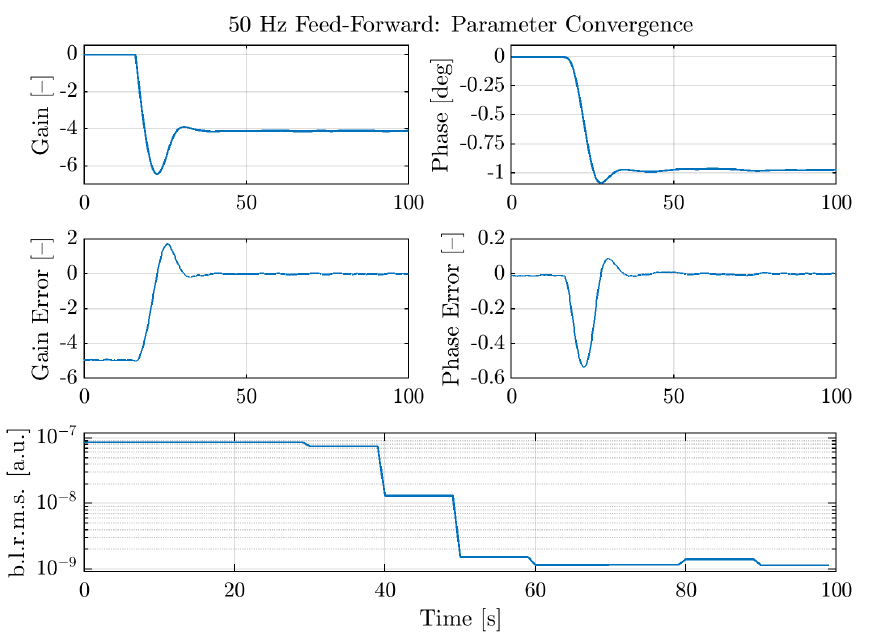
Figure 5. 50Hz Feed-Forward: Convergence of the loop parameters and reduction of the DARM band-limited RMS by two orders of magnitude.